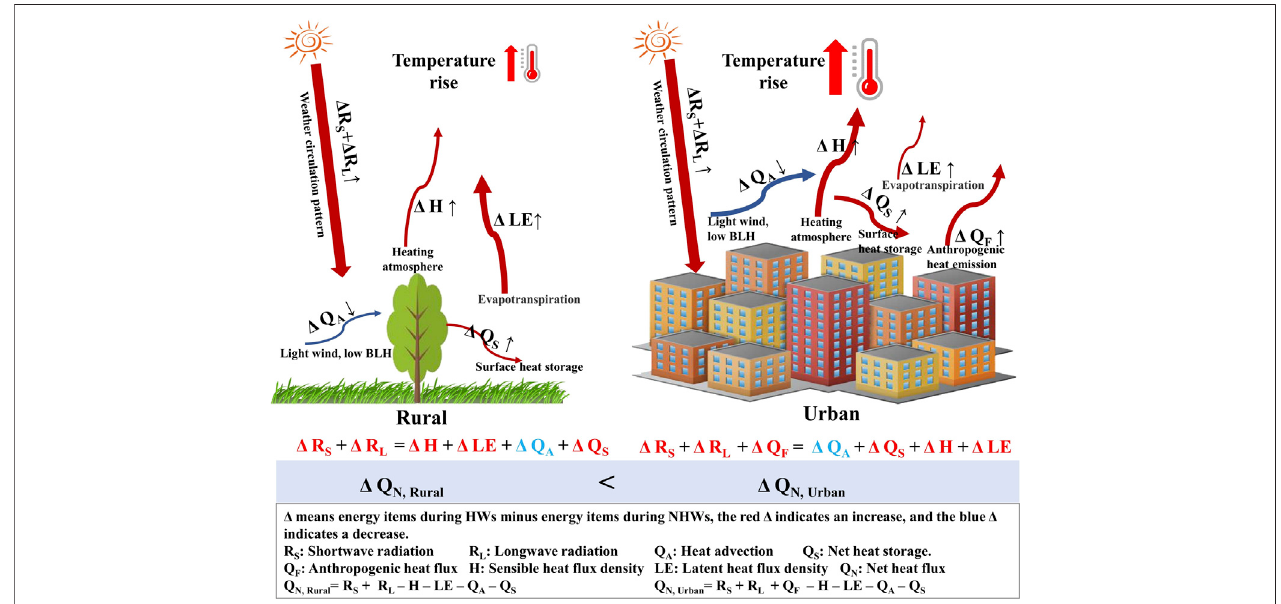
FIGURE 10 | Schematics of mechanisms of HW events enhancing UHI